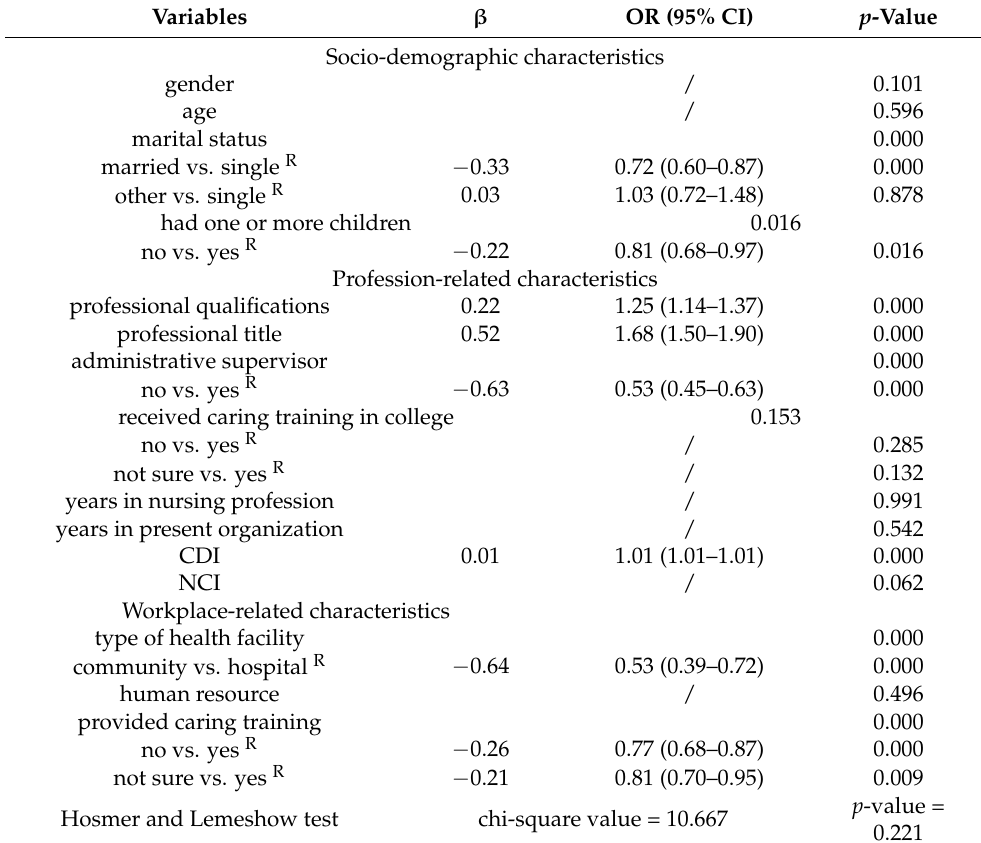
Table 2. Predictors of willingness to participate in the fight against COVID-19 (multivariable logistic